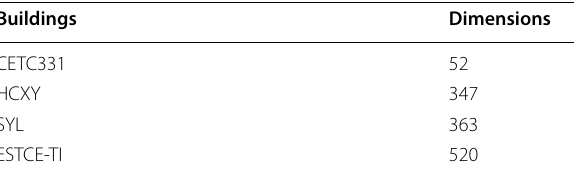
Table 2 Dimensions of RSS vector in different sheets